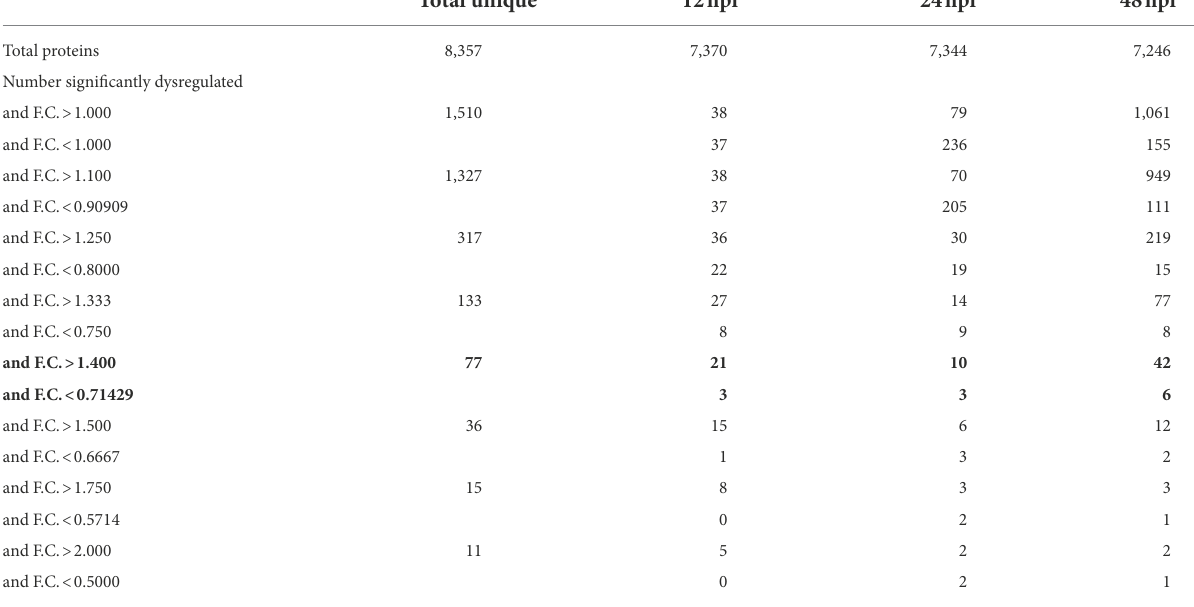
TABLE 1 Numbers of significantly dysregulated OC43-infected MRC-5